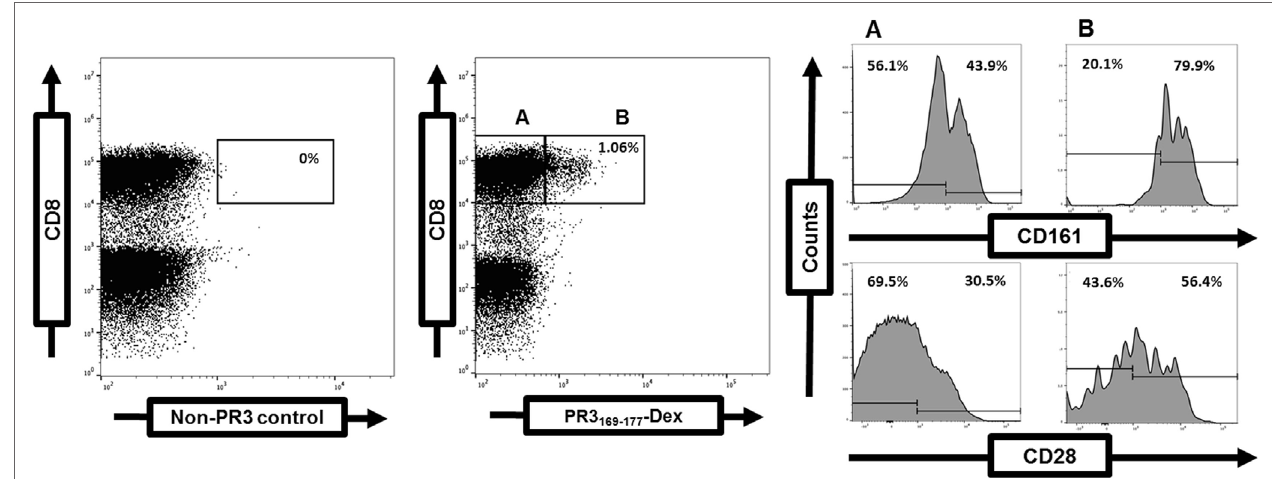
FiGURe 1 | Frequency and phenotype of proteinase 3 (PR3)-specific T-cells determined by flow cytometry . Detection of PR3-specific T-cells within the gated CD3 + CD8 + T-cell population in a GPA-patient (right dot plot). A negative control (left dot plot). Costimulatory CD28 and CD161 expression on gated PR3-specific CD8 + T-cells (A) in comparison to PR3-negative CD8 + T-cells (B) (4).